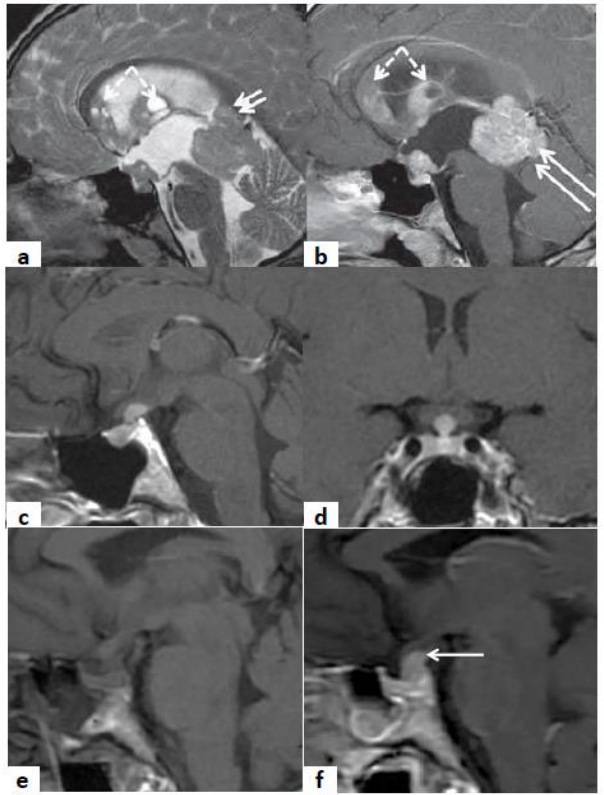
Figure 4. Sagittal T2w ( a ) and CE-T1w ( b ) MR images. A case of a 20-year-old male patient affected